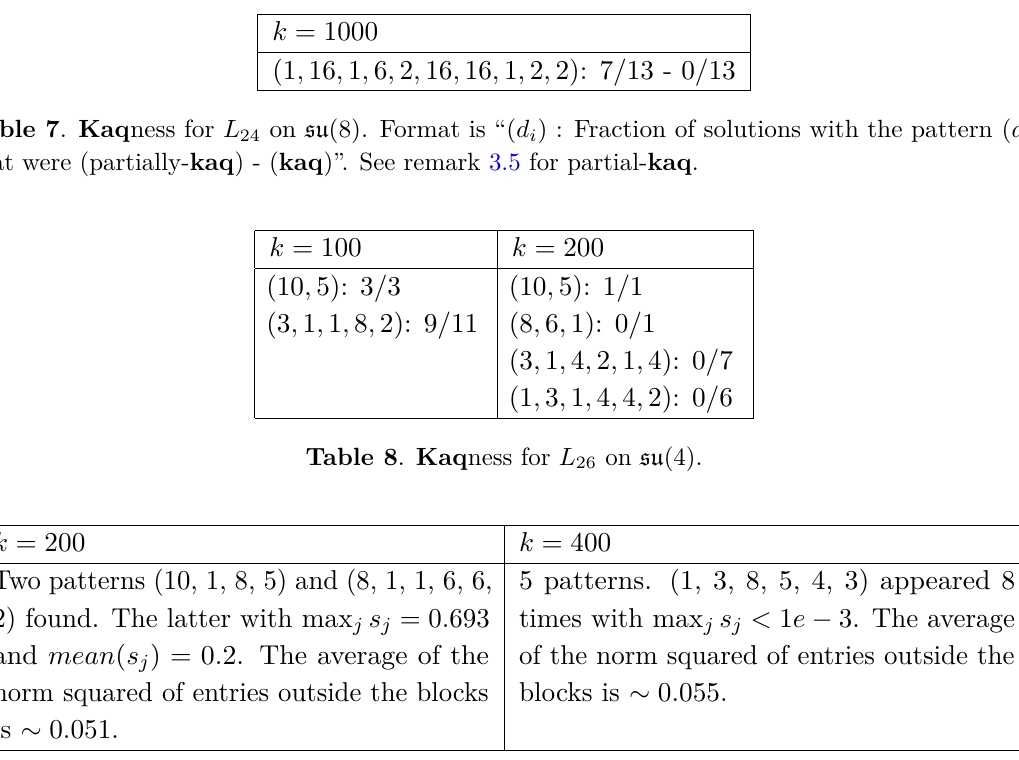
Table 9 . Almost- kaq ness for L 26 on su (5) . See remark 3.6 and section 3.2.3 for how to compute entropy s ( g, θ ) for C 2 ⊗ C 2 ⊕ C . It should be noted that the average of a random entry from an j l 2 -normalized 5 × 5 matrix is 0 . 04 (to be compared with the numbers